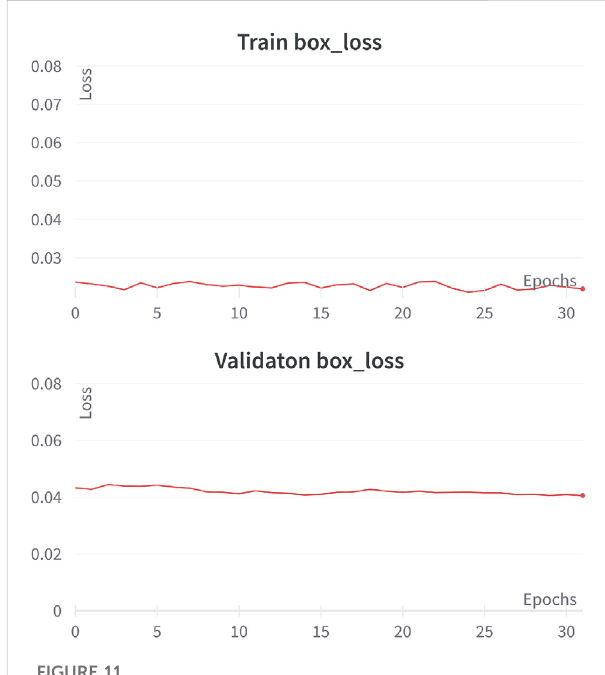
FIGURE 9 Training and validation performances in the box loss function during 400 epochs.